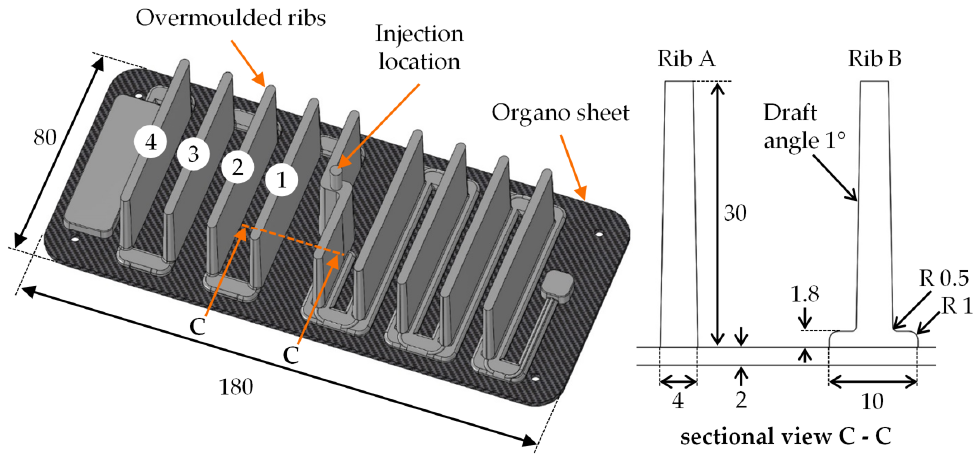
Figure 1. Cross-tension test specimen: rib type A with small base and rib type B with wide base according to [17] (all dimensions in